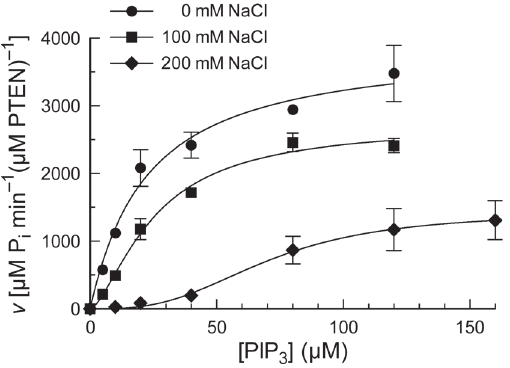
Figure 3. Turnover of PIP 3 by wild-type PTEN in solutions of various salt concentrations. Reactions were performed in 50 mM Tris – HCl buffer, pH 7.6, containing NaCl (0, 100, or 200 mM), EDTA (2.0 mM), MESG (0.20 mM), and DTBA (40 mM), and were initiated with the addition of PTEN to 20 nM. Values are for maximum reaction velocity ( ± SE) at < 10% turnover of substrate in reactions performed in triplicate or more. The resulting kinetic parameters are listed in Table 1.